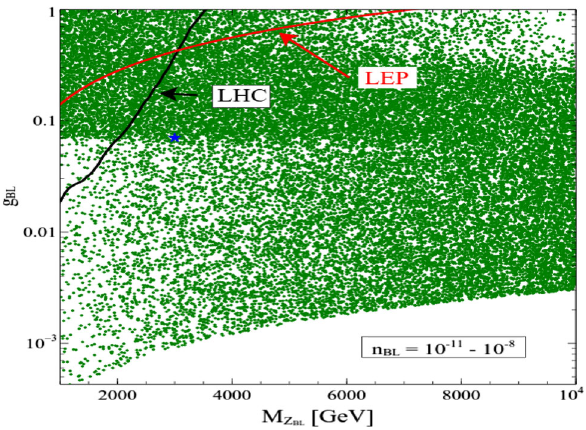
Fig. 14 Allowed region in the M Z – g BL plane which produces BL observed DM relic density. Solid lines (black and red) are the upper limits on the gauge coupling g BL for a particular mass of Z BL obtained from LHC and LEP, respectively. Other relevant parameters used in this plot are 250GeV ≤ M DM ≤ 5000GeV, λ Dh = 7 . 212 × 10 − 14 , λ = 8 . 316 × 10 − 14 , M = 500 GeV, α = 10 − 5 , M DH h 2 = 2000 GeV and M = 2500 GeV M N N 3 1